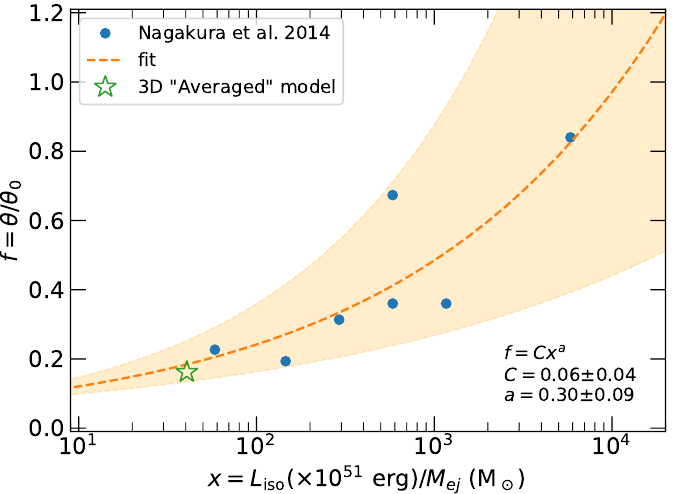
Figure 7. A fit to the ratio of jet power to ejecta mass and the degree of collimation for GRB jets from neutron star mergers. We use the results from 2D simulations in Nagakura et al. [9] (blue circles) for our fit (orange dashed line), and show where our averaged fiducial jet profile fits on this plot (green star). The shaded region shows the a = 0.30 ± 0.09 range. Note—our fiducial jet was not used in the fitting process.